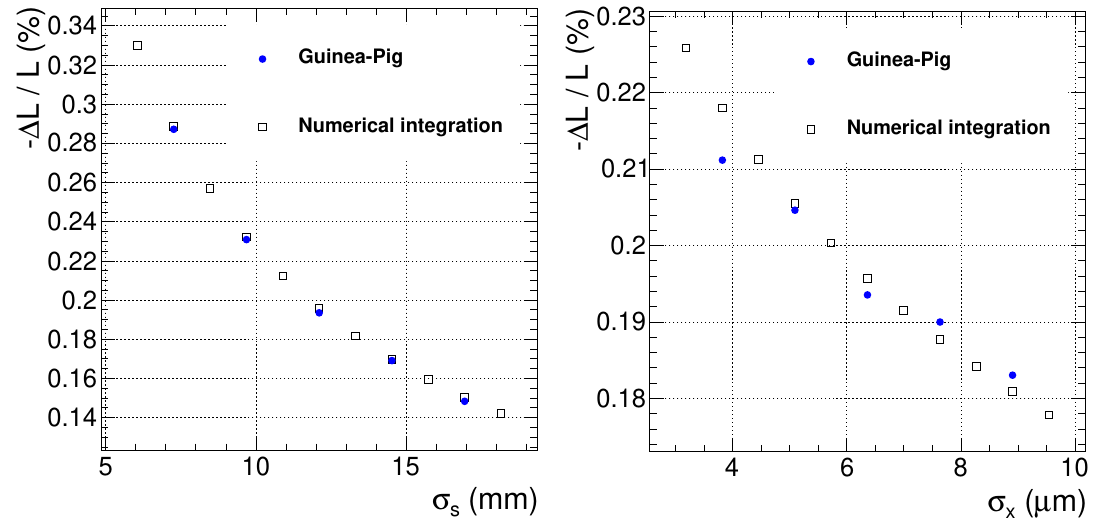
Figure 9 . Variation of the luminosity bias as a function of (left) the longitudinal bunch length and (right) the transverse bunch size along the x direction, as predicted by the Guinea-Pig simulation (closed dots) and by a numerical integration of the average force felt by the electrons (open